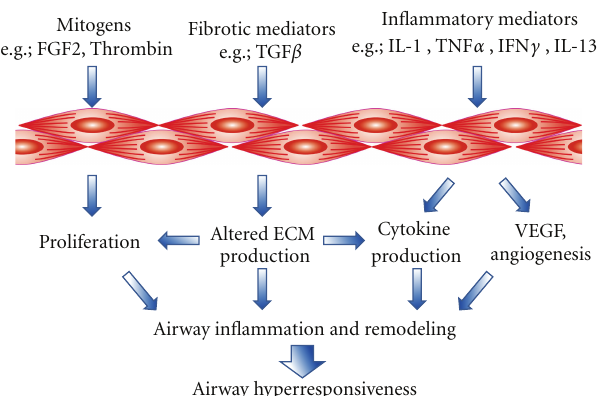
Figure 1: Potential targets for the regulation of noncontractile (proliferative and synthetic) and contractile functions of airway smooth muscle contributing to airway